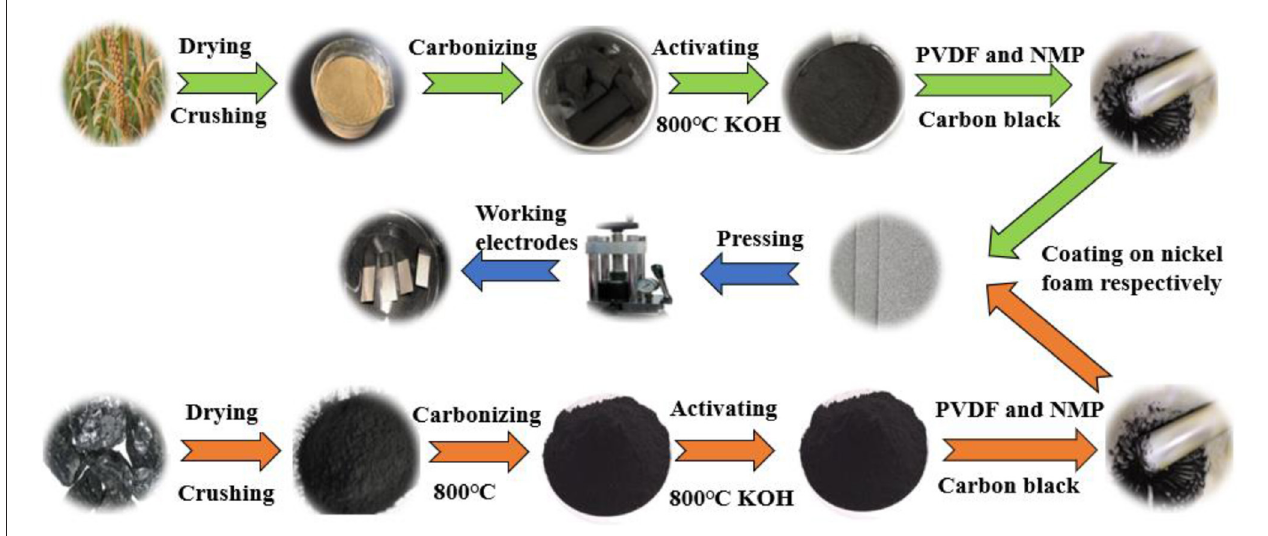
FIGURE 1 | Preparation of modified activated carbon